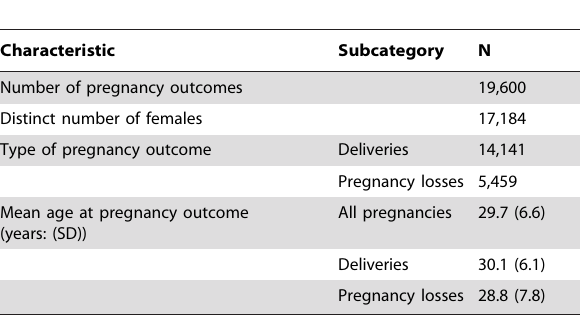
Table 1. Population characteristics for the final asthma- pregnancy cohort.